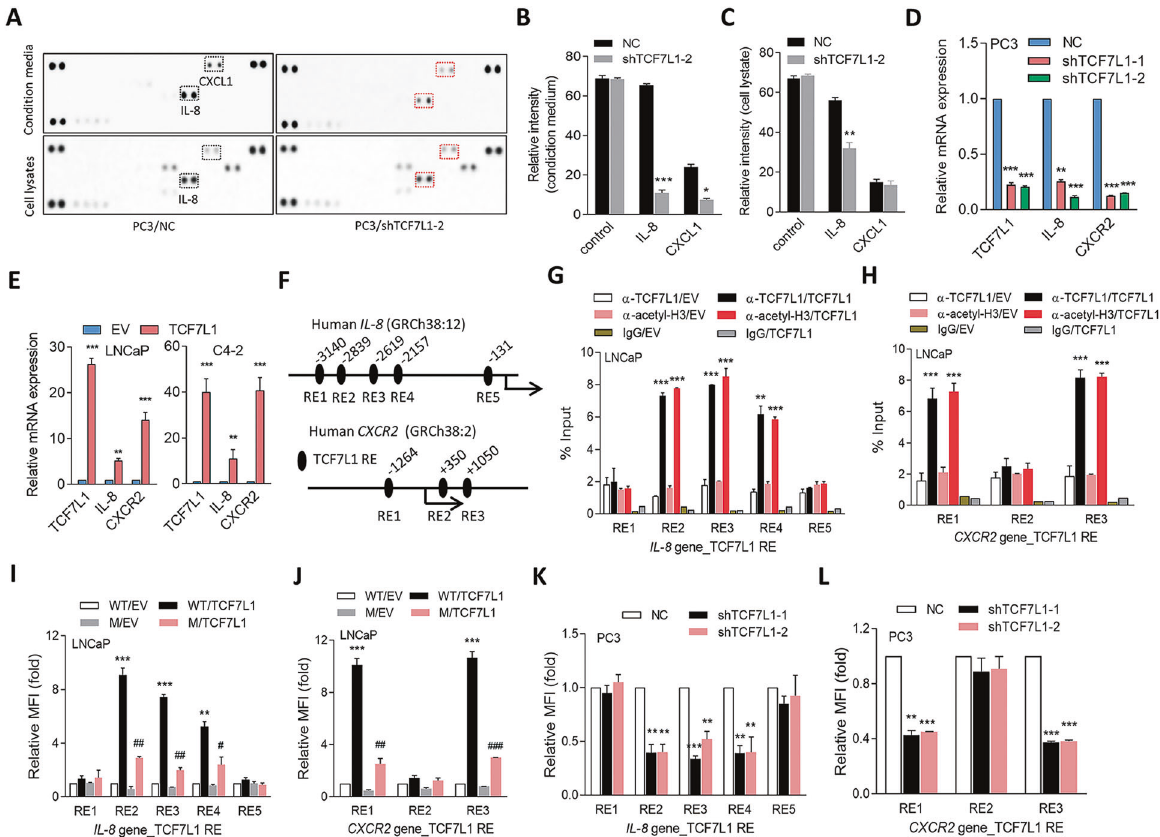
Fig. 2 TCF7L1 upregulates IL-8 and CXCR2 through directly binding to the regulatory sequence of IL-8 and CXCR2 . A Cytokine and chemokine array analysis of PC3 cells stably expressing a nontarget control (NC) or TCF7L1 shRNA vector. Conditioned medium was collected from the supernatant and centrifuged. B , C Intensity of conditioned medium ( B ) and whole-cell lysates ( C ) in the cytokine and chemokine array analysis from A . D RT-qPCR showing TCF7L1, IL-8, and CXCR2 mRNA levels in PC3 cells stably expressing the NC or TCF7L1 shRNA vector. E Relative mRNA levels of TCF7L1, IL-8, and CXCR2 in LNCaP and C4-2 cells stably expressing an empty vector (EV) or a TCF7L1 expression vector, by an RT-qPCR. Data from the quanti fi cation of mRNA are presented as the mean ± SEM; n = 3 per group. * p < 0.05, ** p < 0.01; by a two- way ANOVA. * vs. the EV. F Schematic of the predicted TCF7L1 responsive element (RE) of human IL-8 and CXCR2 regulatory sequences. G , H ChIP assays of LNCaP cells expressing the EV or TCF7L1 cDNA vector with antibodies against TCF7L1 and acetyl-H3 by a pair of primers recognizing indicated TCF7L1-RE sites on IL-8 ( G ) and CXCR2 ( H ) regulatory sequences. Enrichment is given as a percentage of the total input and then normalized to IgG. * vs. the EV. I , J Relative mean fl uorescent intensities (MFIs) of wild-type (W) and mutant (M) IL-8 and CXCR2